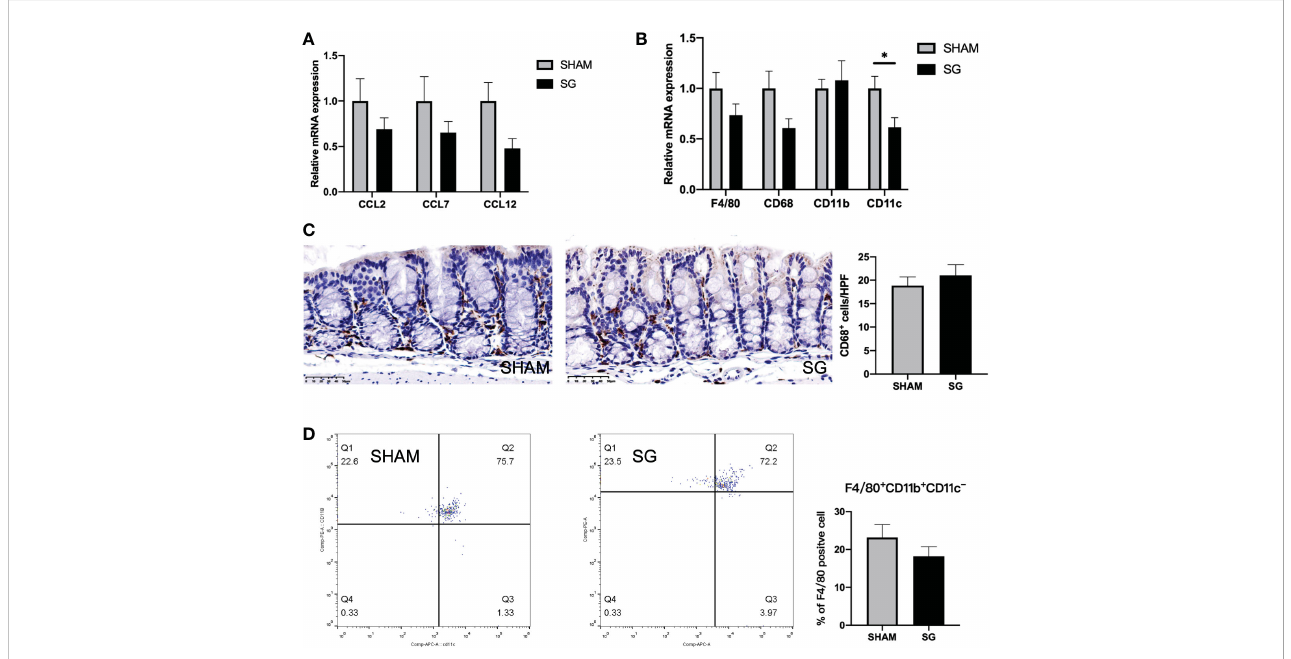
FIGURE 2 HFD feeding induced macrophage in fi ltrations in the colon are not affected by SG. (A) Gene expressions of macrophage-related chemokines. (B) Gene expressions of macrophage-related markers. (C) Representative histological images of colon stained with anti-CD68 antibody (400x; scale bar, 50 um) and quanti fi cation of CD68 positive cells. (D) Representative FACS analysis of F4/80 + CD11b + CD11c - cells in colonic lamina propria. The right panel indicates the percentage of F4/80 + CD11b + CD11c - cells among F4/80+ cells in colonic lamina propria. n = 7 – 9/group; Data are presented as means ± SEM. Student ’ s t-test was used for signi fi cance assessments. *P < 0.05. SHAM, sham surgery; SG, sleeve